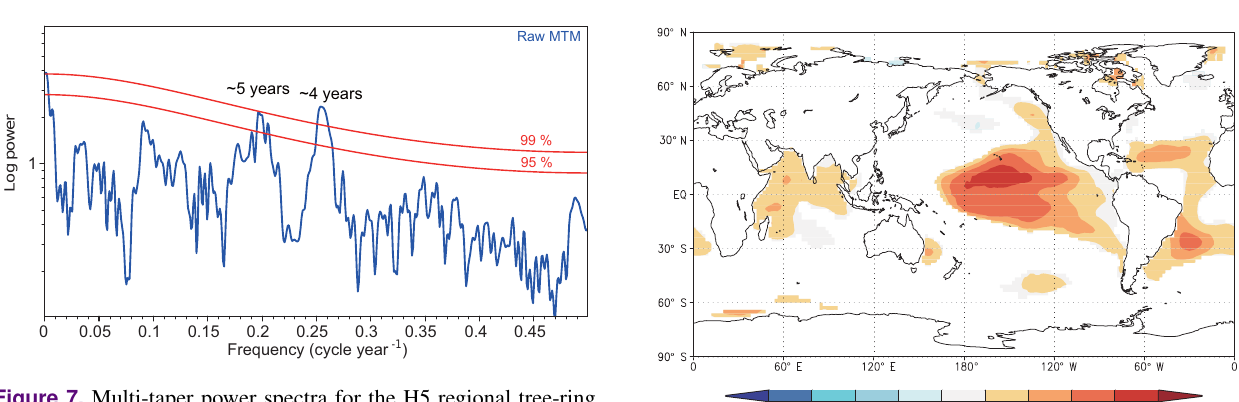
Figure 7. Multi-taper power spectra for the H5 regional tree-ring δ 18 O record.